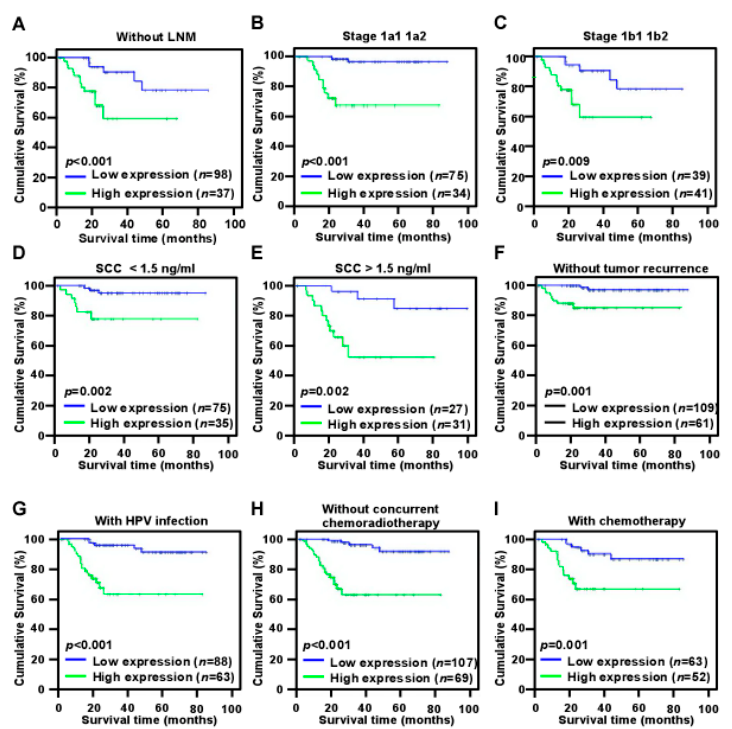
Figure 4. Kaplan–Meier curves of univariate analysis data (log-rank test) of patients with high versus low NR2F6 expression. ( A ) OS of LNM-free patients; ( B ) OS of patients with stage IIA1–IIA2 disease; ( C ) OS of patients with stage IB1–IB2 disease with high versus low NR2F6 expression; ( D ) OS of patients with SCC (squamous cell carcinoma antigen) antigen <1.5 ng/mL; ( E ) OS of patients with SCC antigen >1.5 ng/mL; ( F ) OS of patients without recurrence; ( G ) OS of patients with HPV infection; ( H ) OS of patients without CCRT (concurrent chemoradiotherapy); ( I ) OS of patients who received chemotherapy. Table 4. Cox regression univariate and multivariate analyses of prognostic factors in early-stage cervical